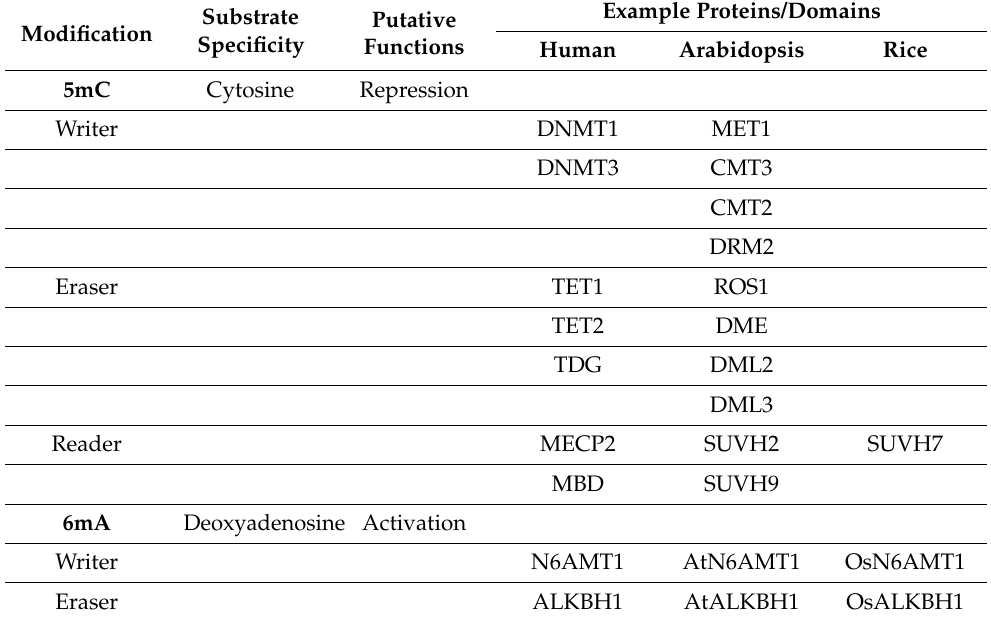
Table 1. Summary of writers, erasers and readers of 5mC and